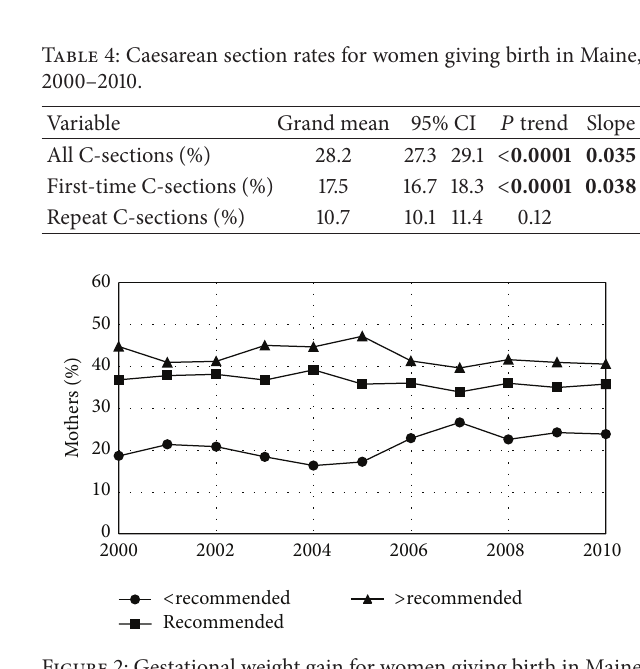
Figure 2: Gestational weight gain for women giving birth in Maine by year. The fraction of women gaining less than the recommended amount of weight increased while the fraction gaining an amount of weight that was within the recommended range or above that range remained unchanged. Healthy People 2020 objectives include an increase in the proportion of women who achieved recommended levels of weight gain during pregnancy (numerical goal under development). Maine is not moving toward this